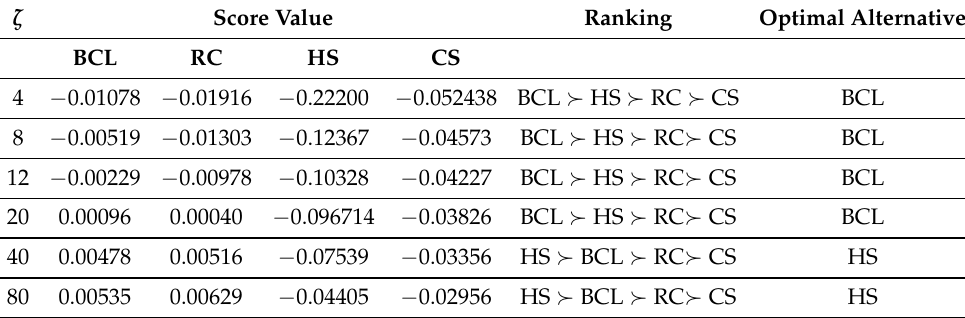
Table 6. Sensitivity analysis regarding the parameter ζ